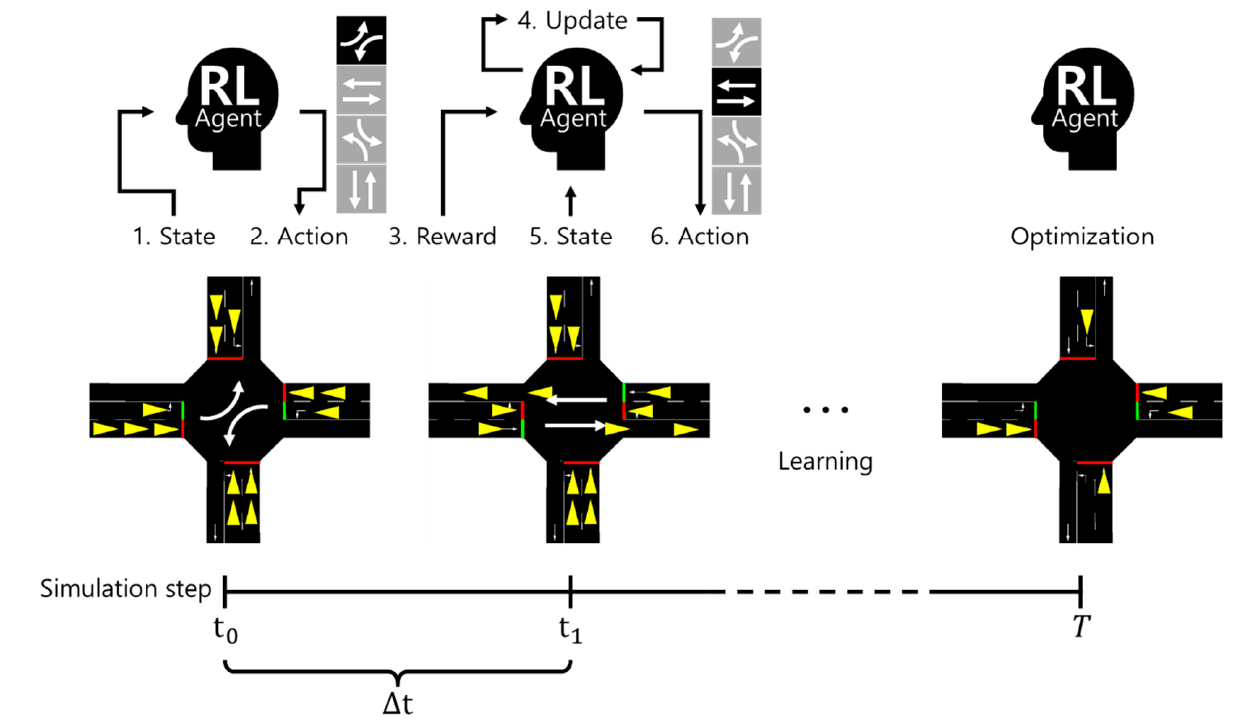
Figure 1. Learning process of the reinforcement learning-based traffic signal control model.